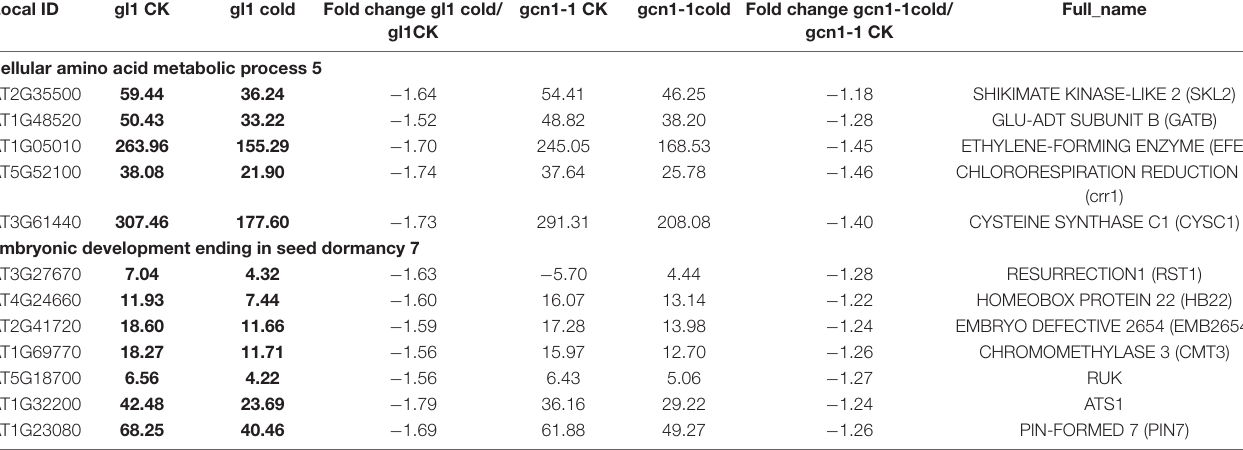
TABLE 1 | Partial classification data of Cold-ATGCN1 down-regulated genes at transcriptional levels. Local ID